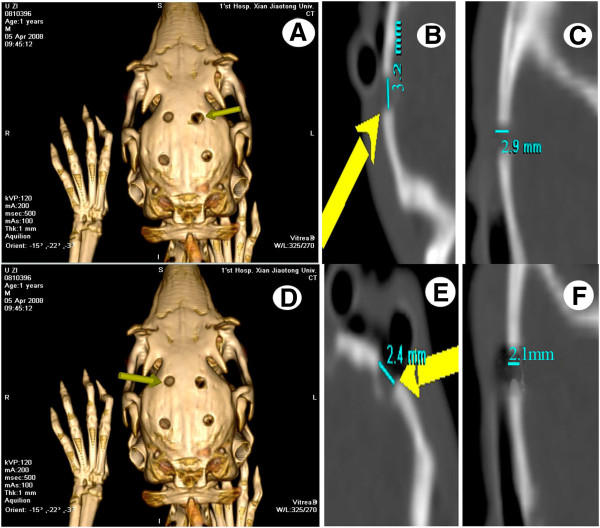
Three-dimensional computed tomography (3D CT) reconstruction of rabbit parietal bones of control (A, B, C) and experimental (D, E, F) groups at 4 weeks after surgery. A and D, images of 3 D CT reconstruction of rabbit parietal bone; B and E present the width of hole of rabbit parietal bone; C and F present the depth of hole of rabbit parietal bone. The hole of rabbit parietal bone in experimental group were smaller than that in control group.